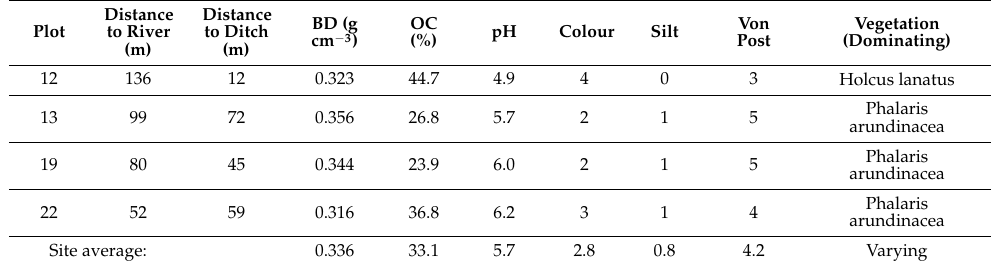
Table 1. Plot-specific and site-averaged soil properties, showing bulk density (BD), the organic carbon content (OC), pH, the von Post degree of humification, and the dominating vegetation type. Distance to River Plot